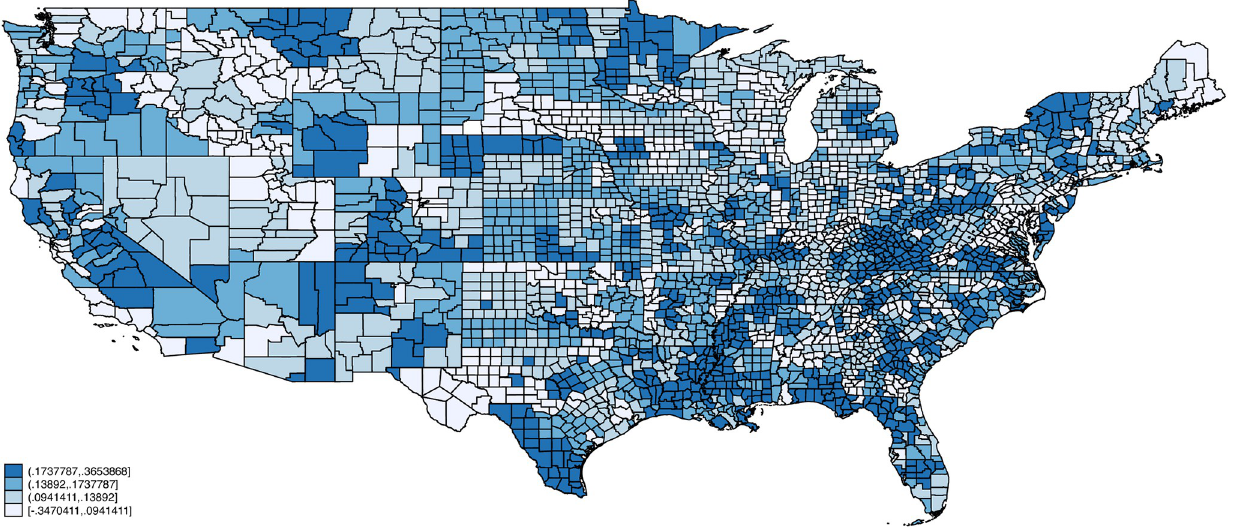
Fig 3. Proximity to coworkers by county. Notes: Each county is assigned the average value of the proximity index based on the distribution of employment across occupations using 2018 American Community Survey (ACS) data. Endpoints correspond to quartiles. Person weights from the ACS are used.